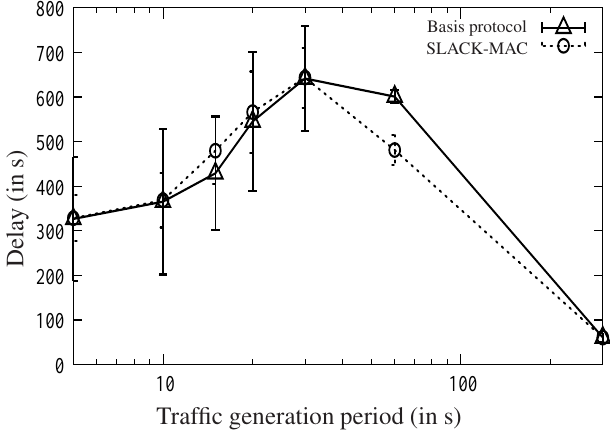
Figure 12. End-to-end delay of data packets as a function of the traffic generation period, for a duty-cycle of 1%, and for the Basic protocol and